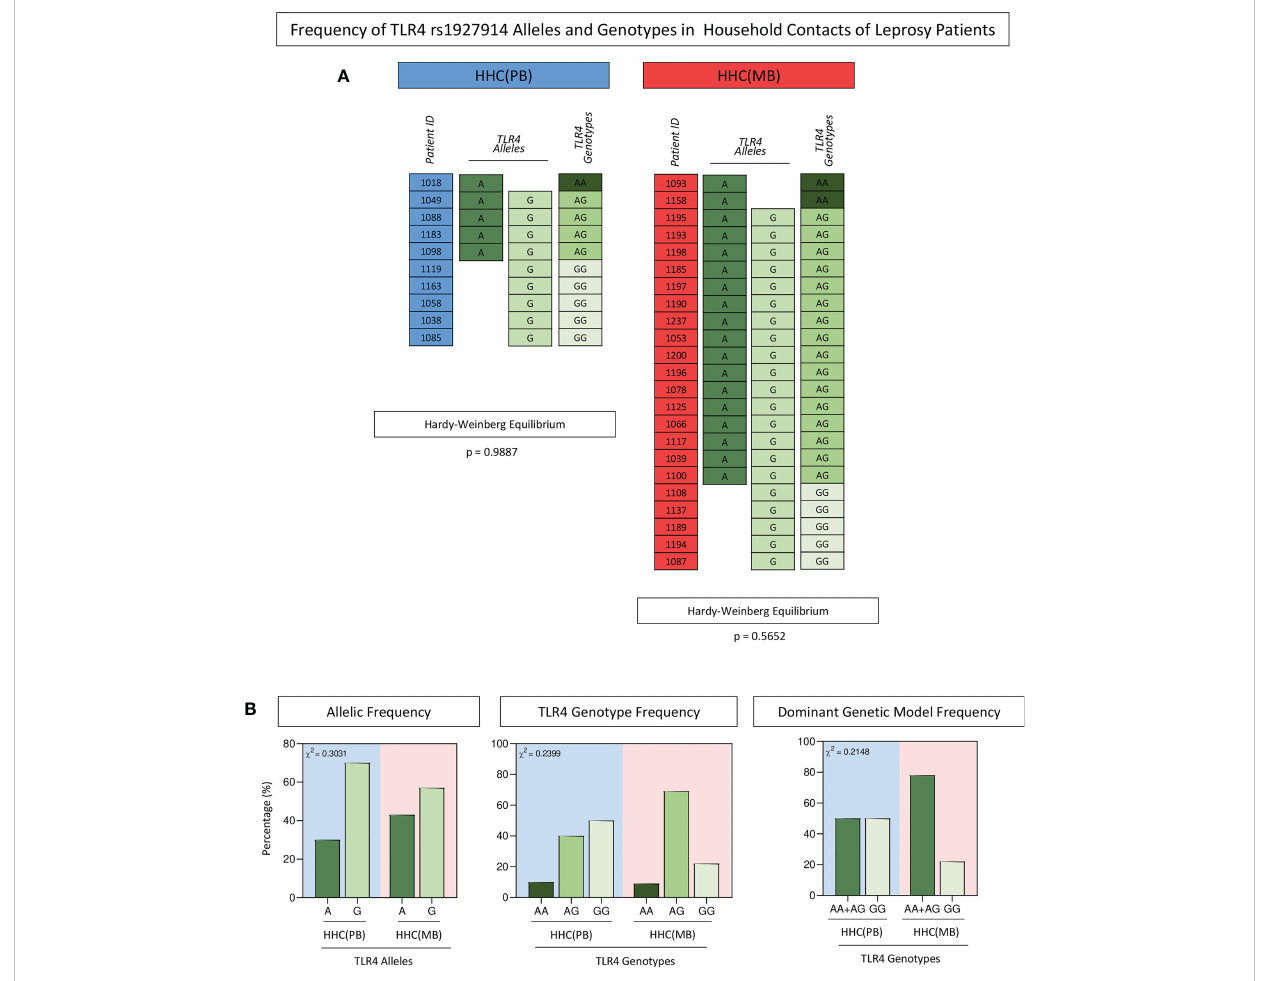
FIGURE 3 Frequency of TLR4 rs1927914 alleles and genotypes in household contacts of leprosy patients. The single nucleotide polymorphisms of TLR4 gene was analyzed as described in methods. (A) Color diagrams illustrate the TLR4 rs1927914 alleles and genotypes pro fi le of household contacts of paucibacillary [HHC(PB) = , n=10] and multibacillary patients [HHC(MB) = , n=27]. (B) The allelic (A = and G = ), genotypic (AA= , AG = and GG = ) and dominant genetic model (AA+AG = and GG = ) frequencies are shown in bar charts as percentage of subjects within HHC(PB) and HHC(MB) ( and background, respectively). Comparative analysis of TLR4 rs1927914 alleles and genotypes frequencies between groups was carried out by Chi-square test ( c 2) and p values provided in the fi gure. In all cases, signi fi cance was considered at